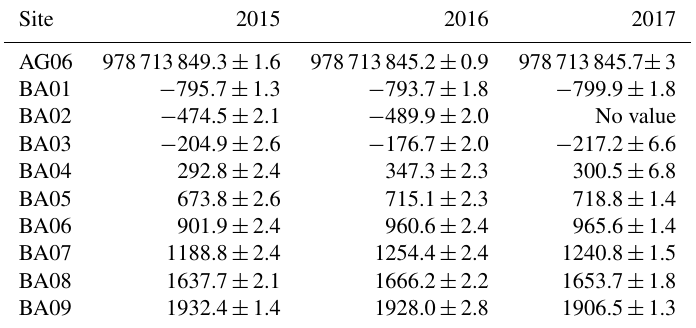
Table 5. Gravity values measured at each site for all surveys (in µGal). The values at each relative gravity site (BA) are given relative to the absolute value measured at